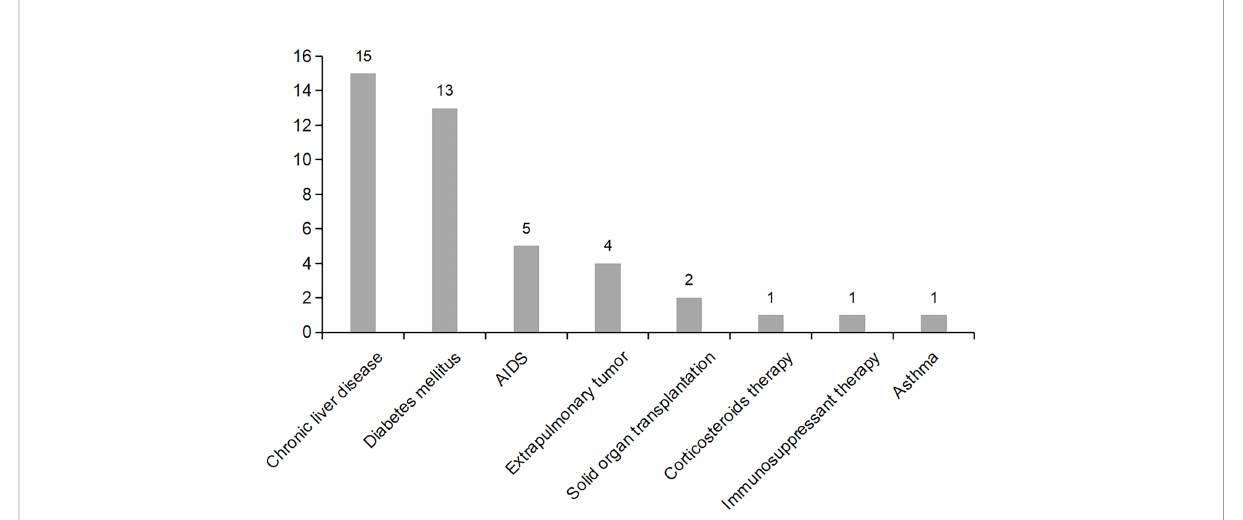
FIGURE 1 Distribution of major comorbidities in patients with positive T. whipplei in